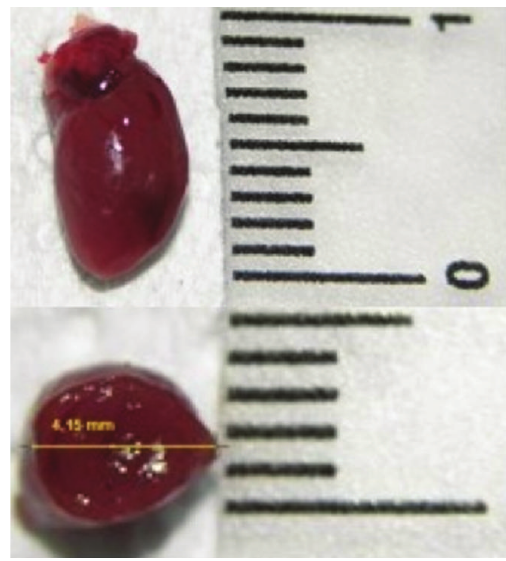
Figure 1: Longitudinal and transversal dimensions (mm) of mouse